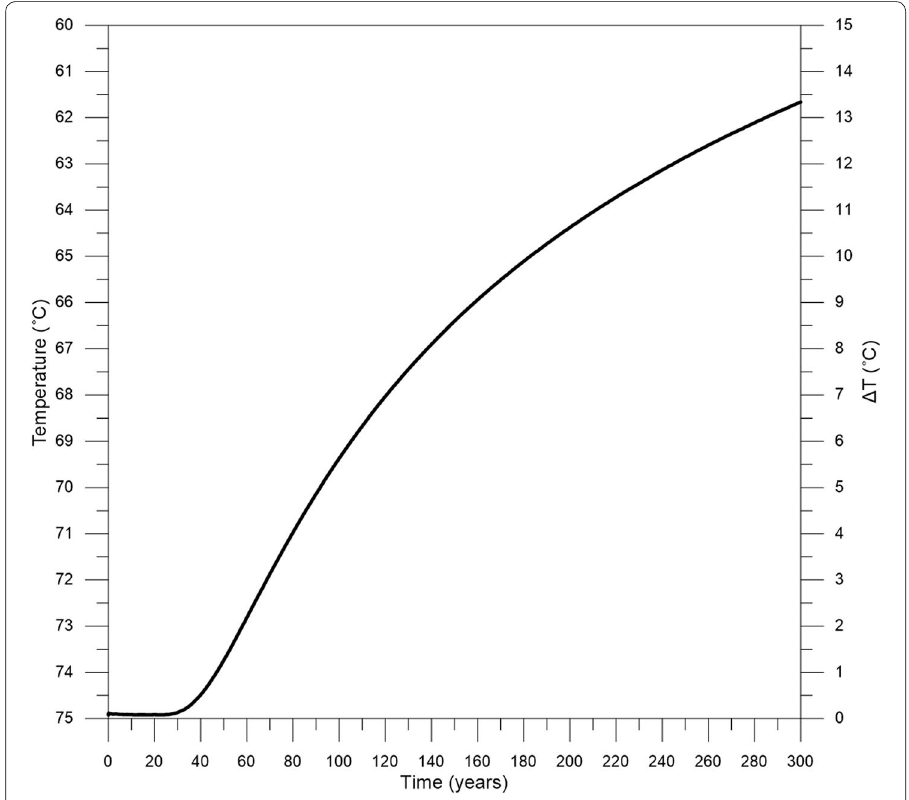
Fig. 2 Temperature profile at the reservoir level in P1 during a 300-year model simulation with combined production and